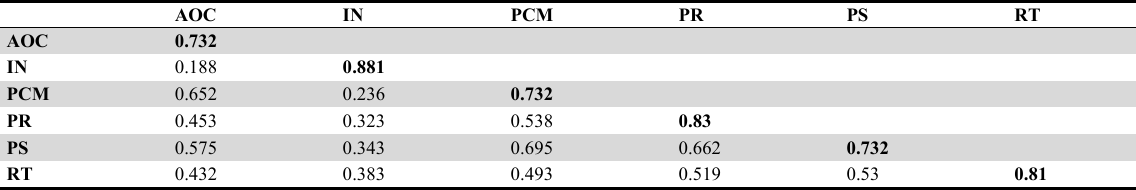
Fornell-Larcker criterion